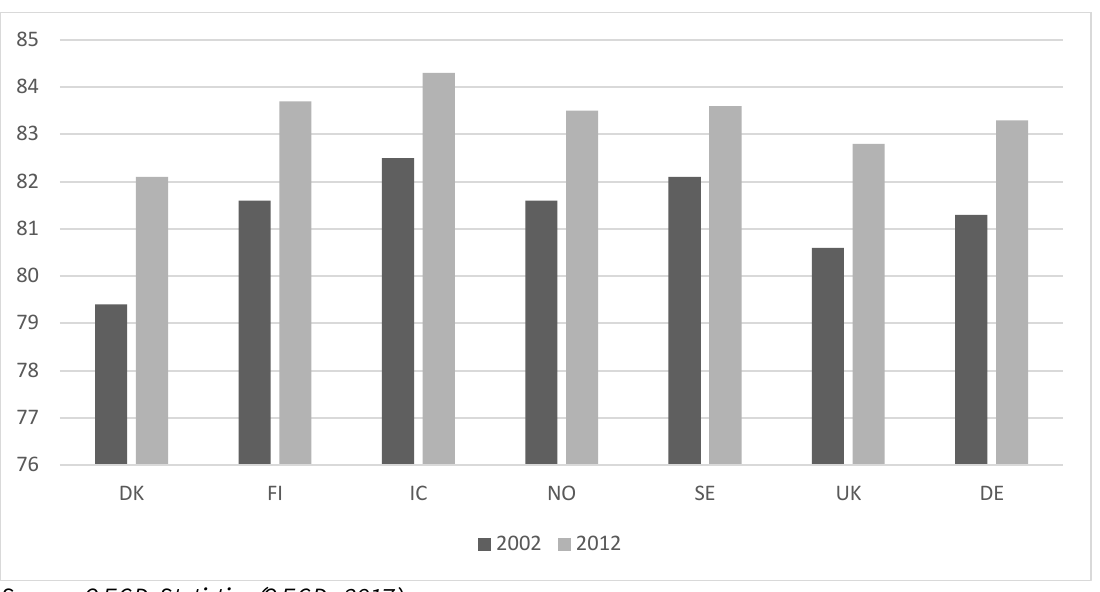
Source: OECD Statistics (OECD, 2017).